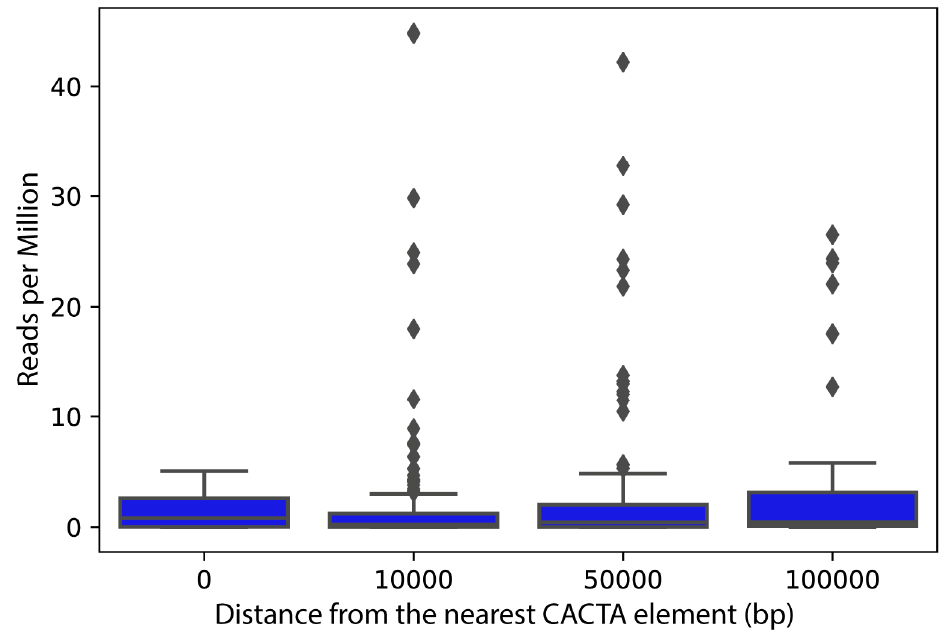
Figure 7. Expression (in mapped reads per million) of sunflower genes according to the distance from CACTA elements.